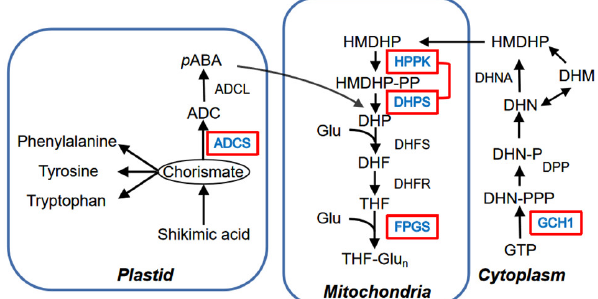
Figure 5. Schematic representation of the folate biosynthesis pathway in plants. Chemical com-